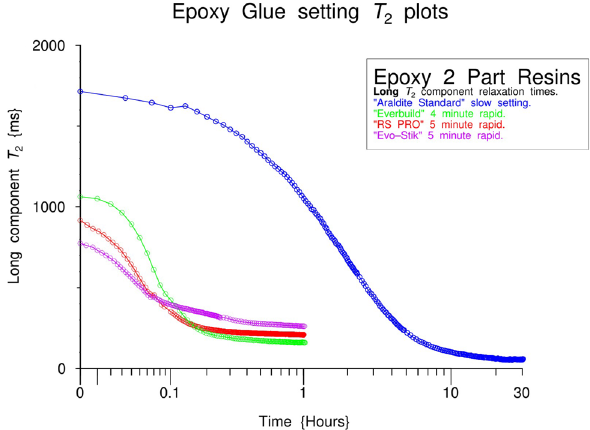
Fig. 16 Molecular mobility changes in reacting Epoxy Resins, moni- tored by time-domain NMR